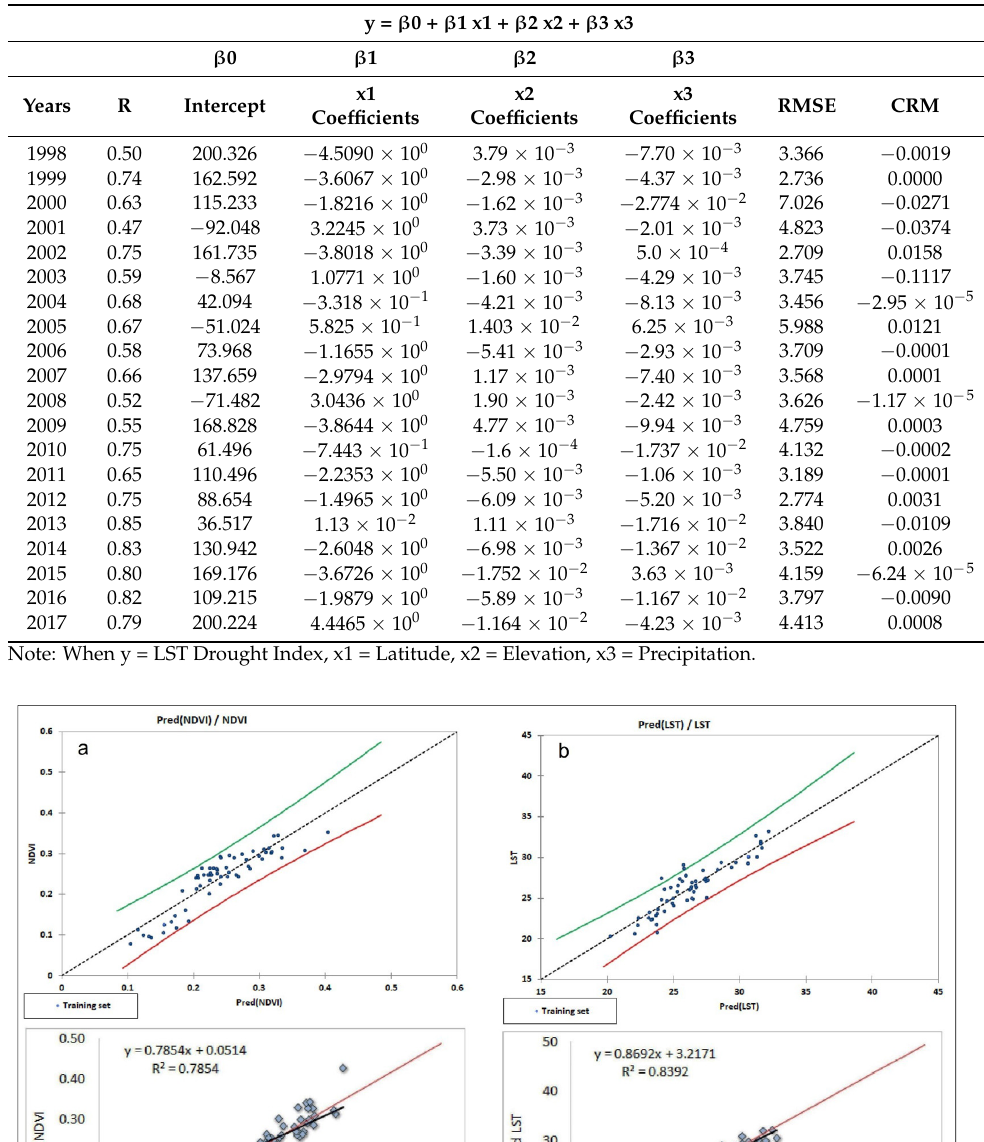
Table 9. Parameters of the regression models used for predicting drought index (LST) in KRI.